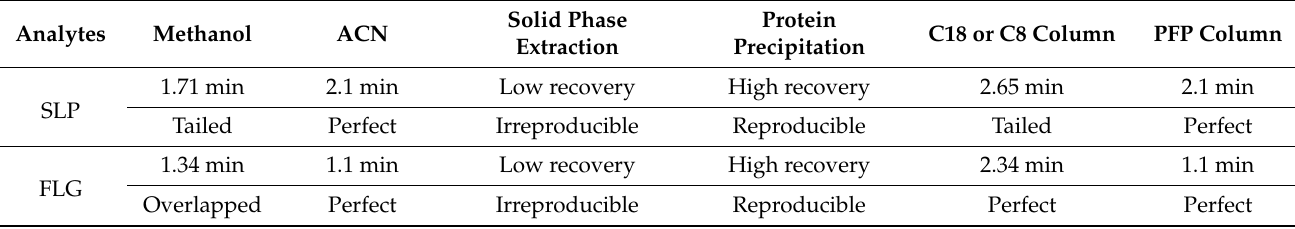
Table 4. Various experiments for resolution of SLP and FLG